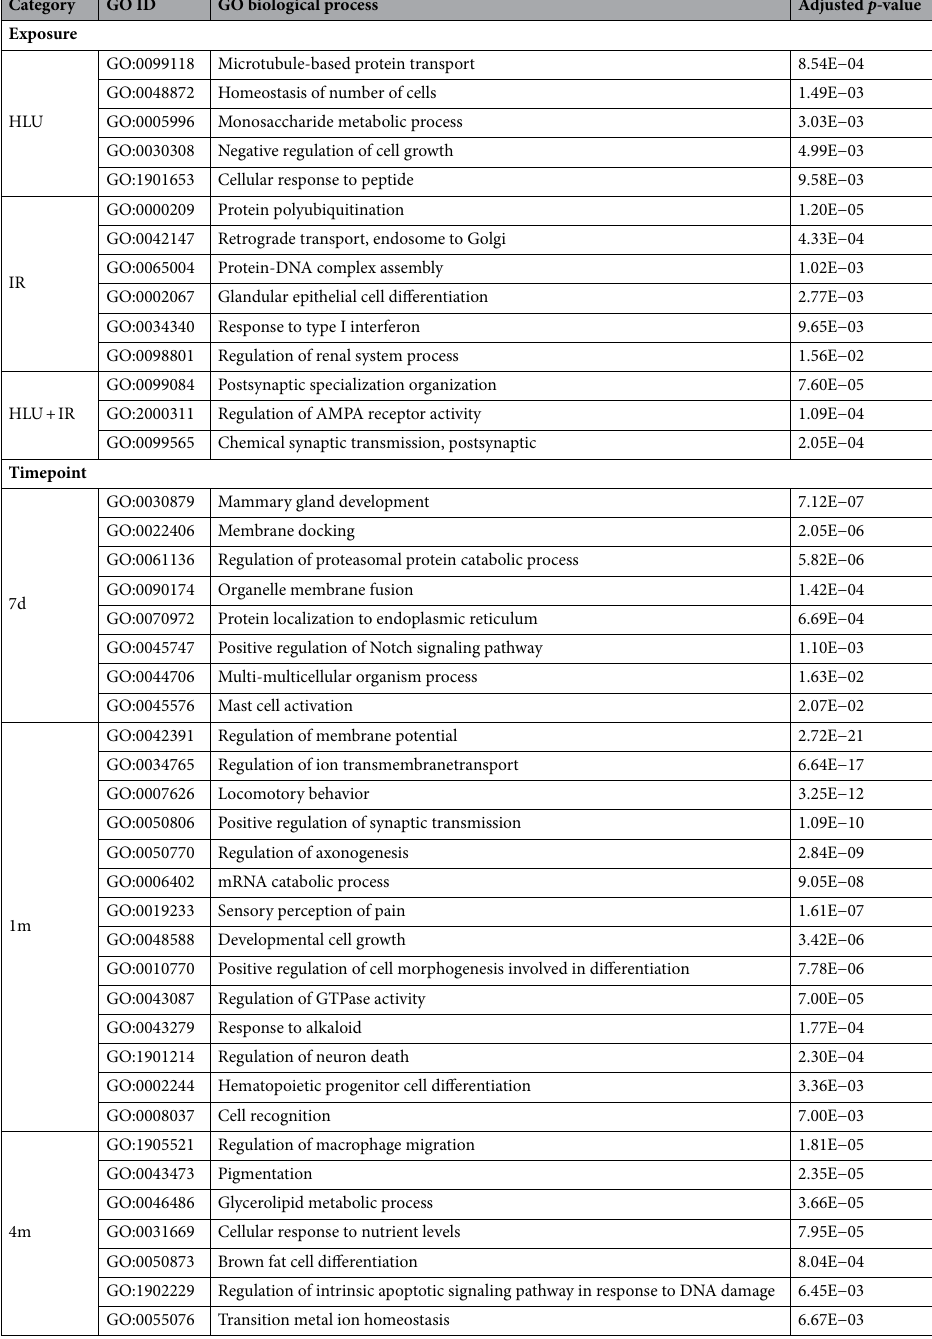
Table 2. Representative biological processes enriched exclusively under each exposure condition or timepoint. REVIGO was used for reducing significant biological processes (adjusted p -value ≤ 0.05) exclusive to each exposure condition (HLU, IR, HLU + IR) or timepoint (7d, 1m, 4m) to representative non-redundant